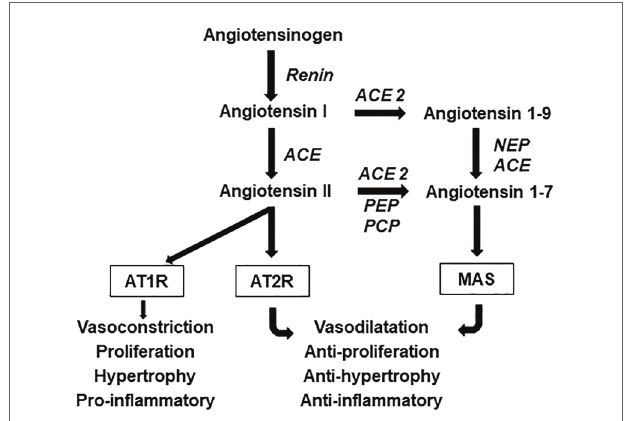
FIGURE 1 | Components and effects of the renin angiotensin system (RAS). The angiotensinogen is cleaved by renin to form angiotensin I. The angiotensin-converting enzyme (ACE) cleaves angiotensin I to form the angiotensin II (Ang II), which can be catabolized by angiotensin converting enzyme 2 (ACE2) into angiotensin 1–7 (Ang 1–7), another active peptide of this system which typically opposes the actions of Ang II. Most effects of Ang II are mediated by the angiotensin type 1 receptor (AT1R), however, Ang II can also bind to the angiotensin type 2 receptor (AT2R), which generally exhibits opposing effects to those at the AT1R. Ang 1–7 acts via the Mas receptor. Endopeptidases and carboxypeptidase also cleave Ang II and Ang 1–9 to form Ang 1–7. NEP, neutral-endopeptidase; PEP, prolyl-endopeptidase; and PCP,